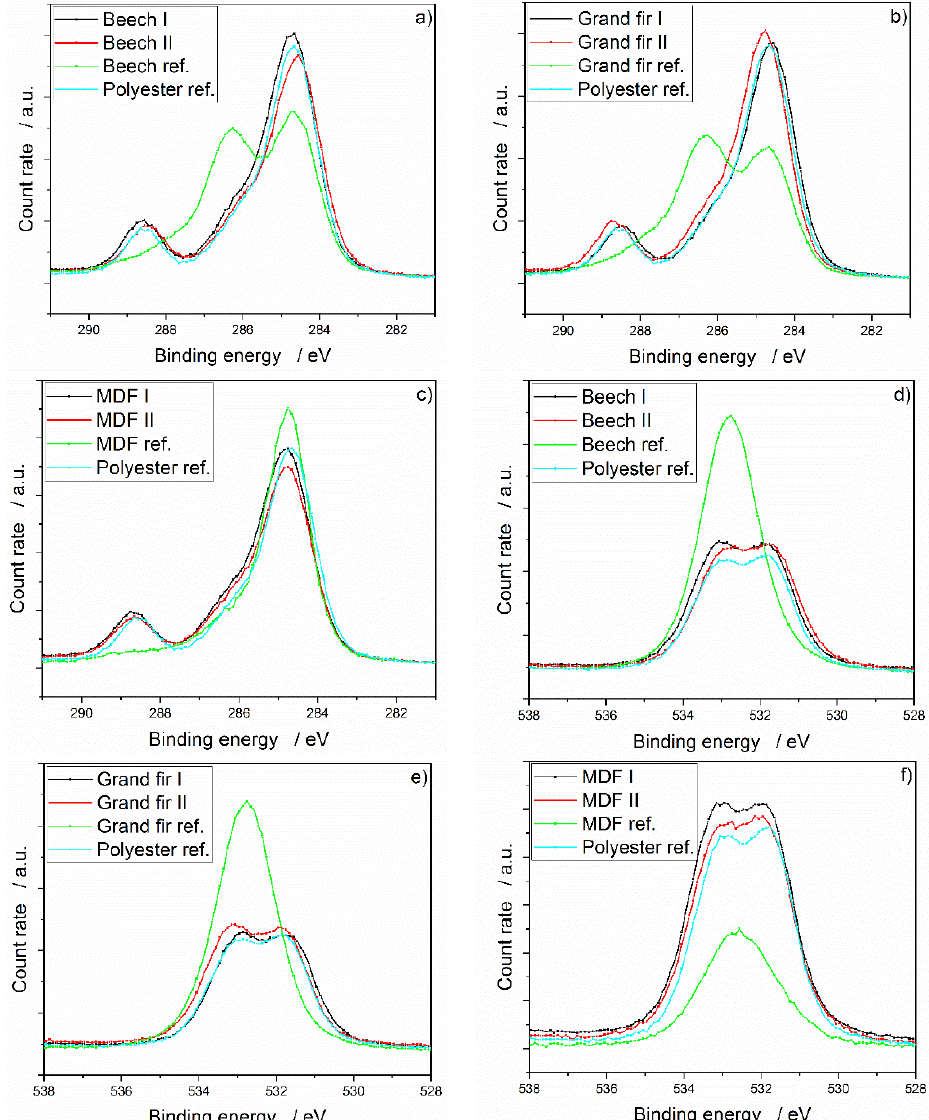
Figure 3 . Comparison of XPS measurements of untreated reference, single-, double-coated and polyester reference: ( a ) C1 s European beech; ( b ) C1 s Grand fir; ( c ) C1 s MDF; ( d ) O1 s Beech; ( e ) O1 s Grand fir; ( f ) O1 s MDF.